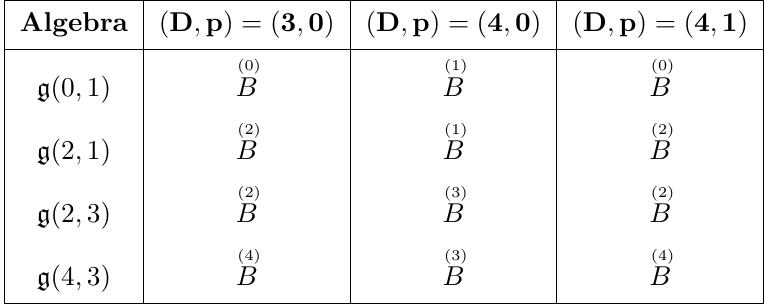
( n ) B that 0 ; N 1 ) the highest order term